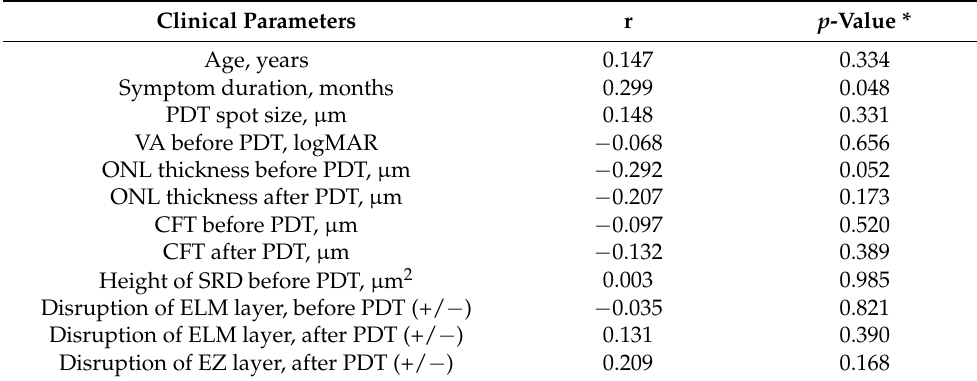
Table 4. Correlation between 6% contrast visual acuities after reduced-fluence photodynamic ther- apy and clinical parameters at pre- and post-treatments.